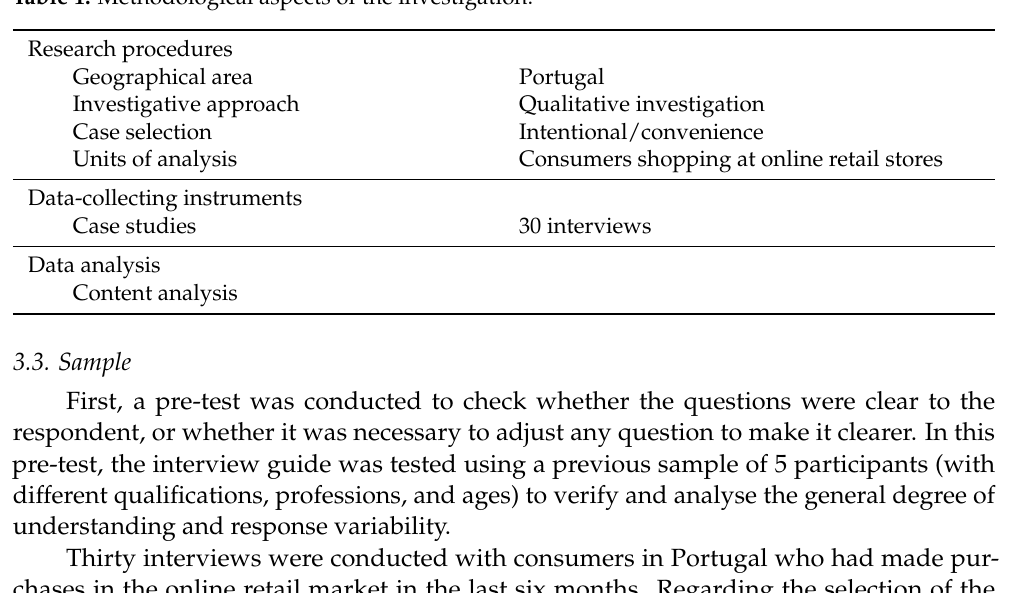
Table 1. Methodological aspects of the investigation.